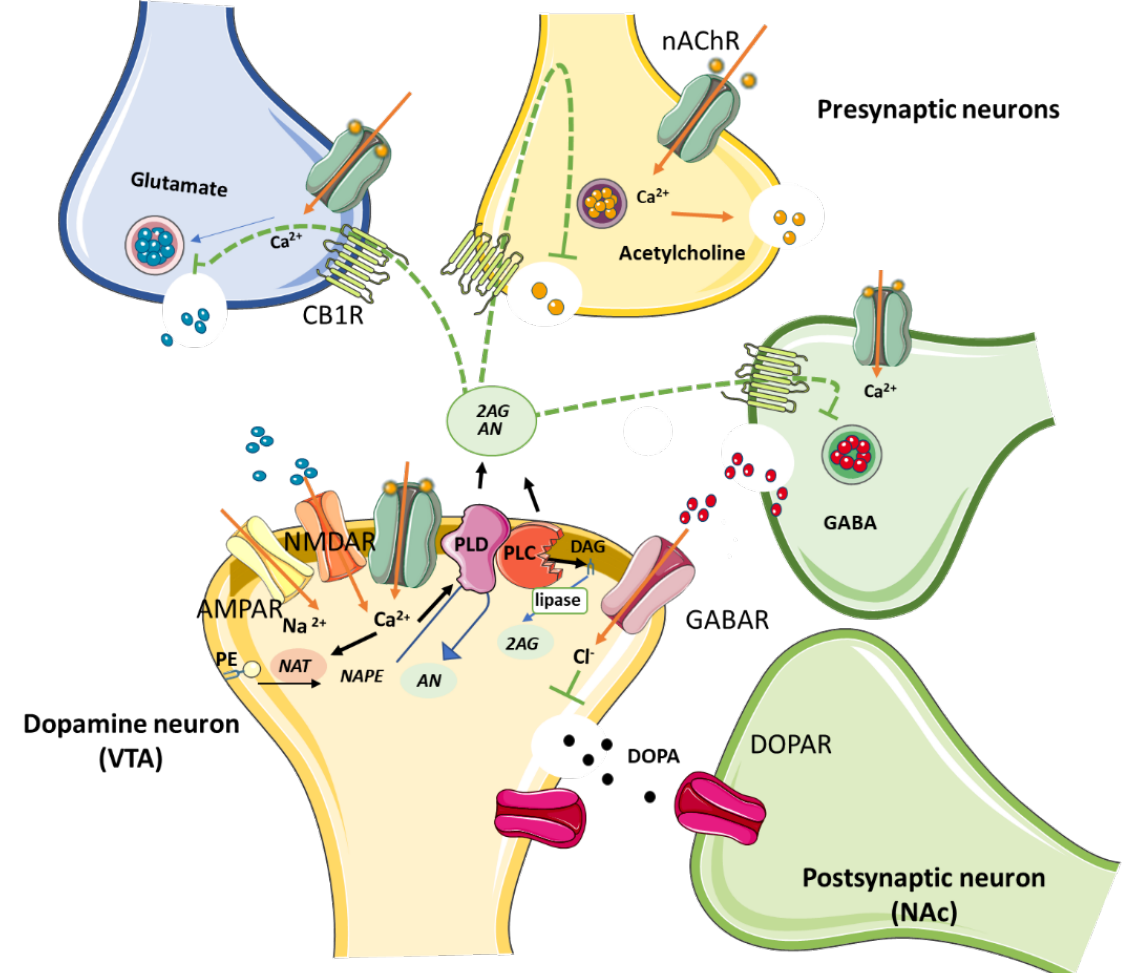
Figure 1. Schematic illustration of the biosynthetic pathway followed by ECs N-acylethanolamine (AN) and 2-arachidonoylglycerol (2-AG) by NAPE-PLD and DAG lipase, respectively. Both AN and 2-AG bind to presynaptic CB1Rs expressed on GABAergic, glutamatergic and cholinergic terminals, precluding neurotransmitter release. Induction of DOPA secretion by primary inhibition of GABA release is involved in the reward pathway in the brain. Abbreviations: PLD, N-acyl phosphatidylethanolamine phospholipase D; DAG, diacylglycerol; NAT, N-acyltransferase; PE, Phosphatidylethanolamine; nAChRs, nicotinic acetylcholine receptors; CB1R, cannabinoid type 1 receptor; AMPA, amino-3-hydroxy-5-methyl-4-isoazolepropionate receptor; GABA, γ -aminobutyric acid; GABAR, GABA receptor; NMDAR, N-methyl-D-aspartate receptor; DOPA, dopamine; DOPAR, DOPA receptor; VTA, ventral tegmental area; NAc, nucleus accumbens.